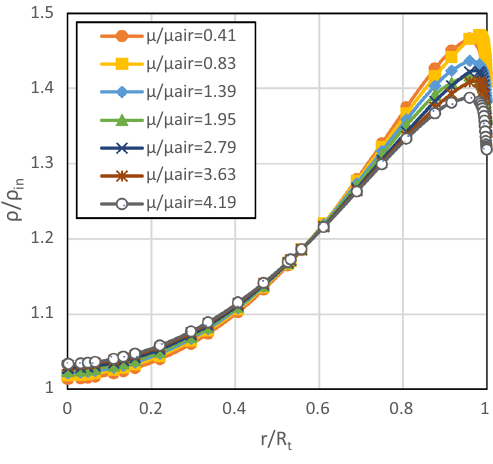
11.11.21.31.41.5 Fig. 20 Dimensionless density profiles versus dimensionless radial direction plotted at z∕L = 0.63 for various dynamic viscosity ratios with 400 kPa at the inlet, 0 kPa at the cold outlet and 30 kPa at the hot